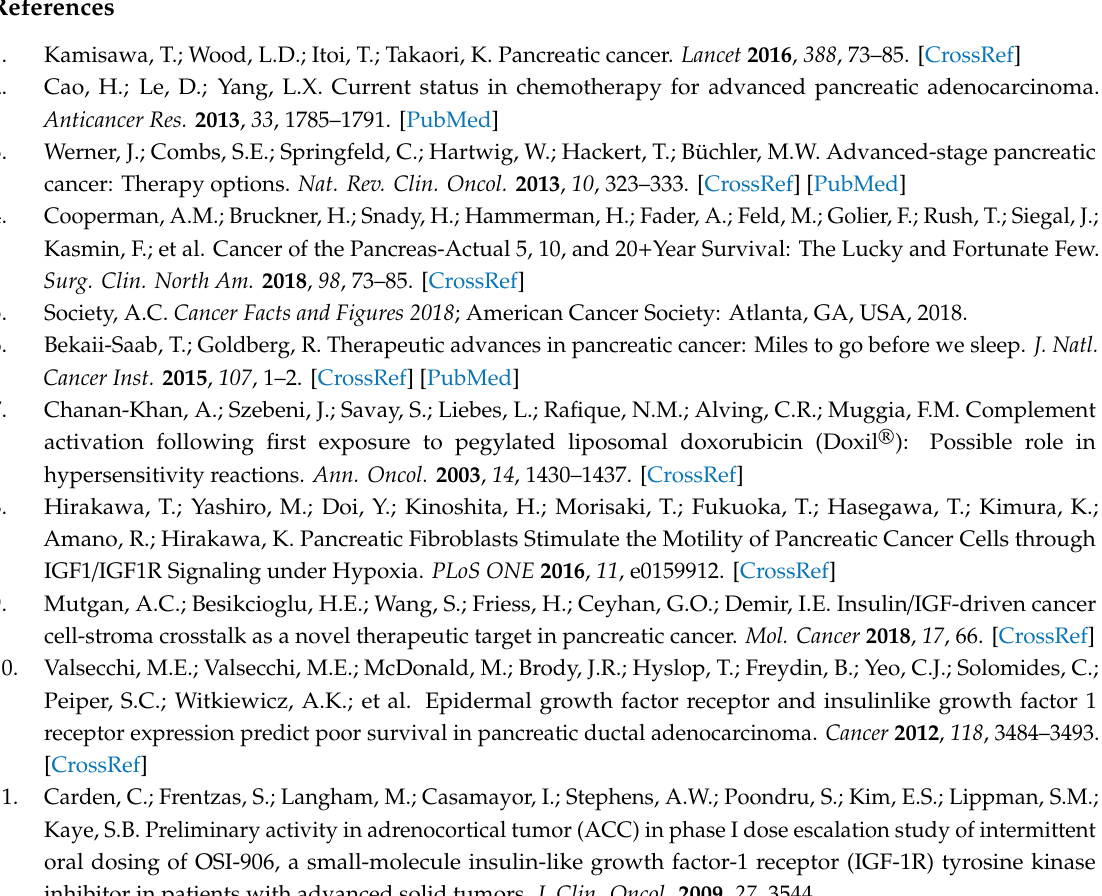
Figure S1: Western blot shows relative levels of insulin-like growth factor 1-receptor (IGF1-R) in pancreatic cancer cell lines, Figure S2: Characterization of liposomes, Figure S3: Tissue-mimicking phantoms indicate relative level of SDC1-Lip uptake in IGF1-R-low (MCF7) and pancreatic cells. Cells were plated in 6-well plates, treated with SDC1-Lip or untargeted liposome containing IR-780 dye as in flow cytometry, Figure S4: Evaluation of HIF1- α and BNIP3 expression in pancreatic cancer cell lines in normoxia and hypoxia, Figure S5: Evaluation of bafilomycin a1 combined with echinomycin in pancreatic cancer cells, Figure S6: Dosimetry of Western blots containing CL3-I, -II, and ATG 7 data from Figure 3, Figure S7: Assessment of extracellular ATP levels of S2VP10 and S2CP9 under normoxia and hypoxia following echinomycin or SDC1-echinomycin